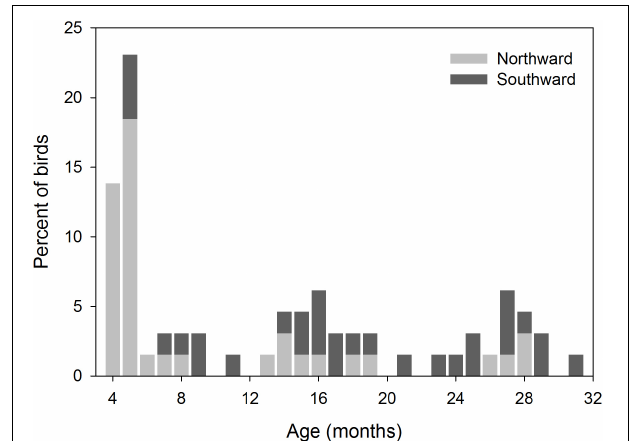
FIGURE 9 | Minimum age at which young bar-tailed godwits ( n = 65) made their last regional movements within New Zealand before becoming migratory adults.